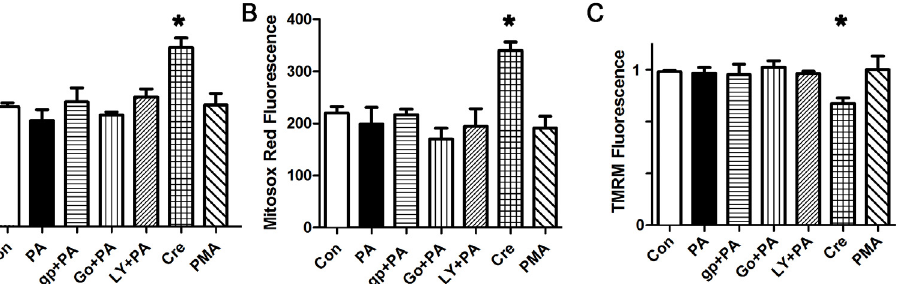
Fig 6. NOX2 KO cardiomyocytes do not have an increase in ROS in response to palmitate or PKC activation. A. Representative experiment done with cardiomyocytes in triplicate, height is DCF fluorescence minus background, in live cells, expressed in arbitrary units, mean + SEM. B. Cardiomyocytes from the same experiment using mitosox red readout. C. Cardiomyocytes from the same experiment using TMRM readout. For all panels, means are significantly different by ANOVA, * = sig different from control by Dunnett post-hoc test. PA = palmitate 200 μ M, gp = gp91ds peptide 50 μ M, Go = Go6983 5 μ